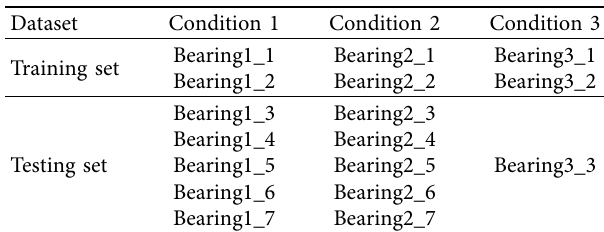
Figure 3: The experiment platform. Table 1: The experimental conditions. Table 2: